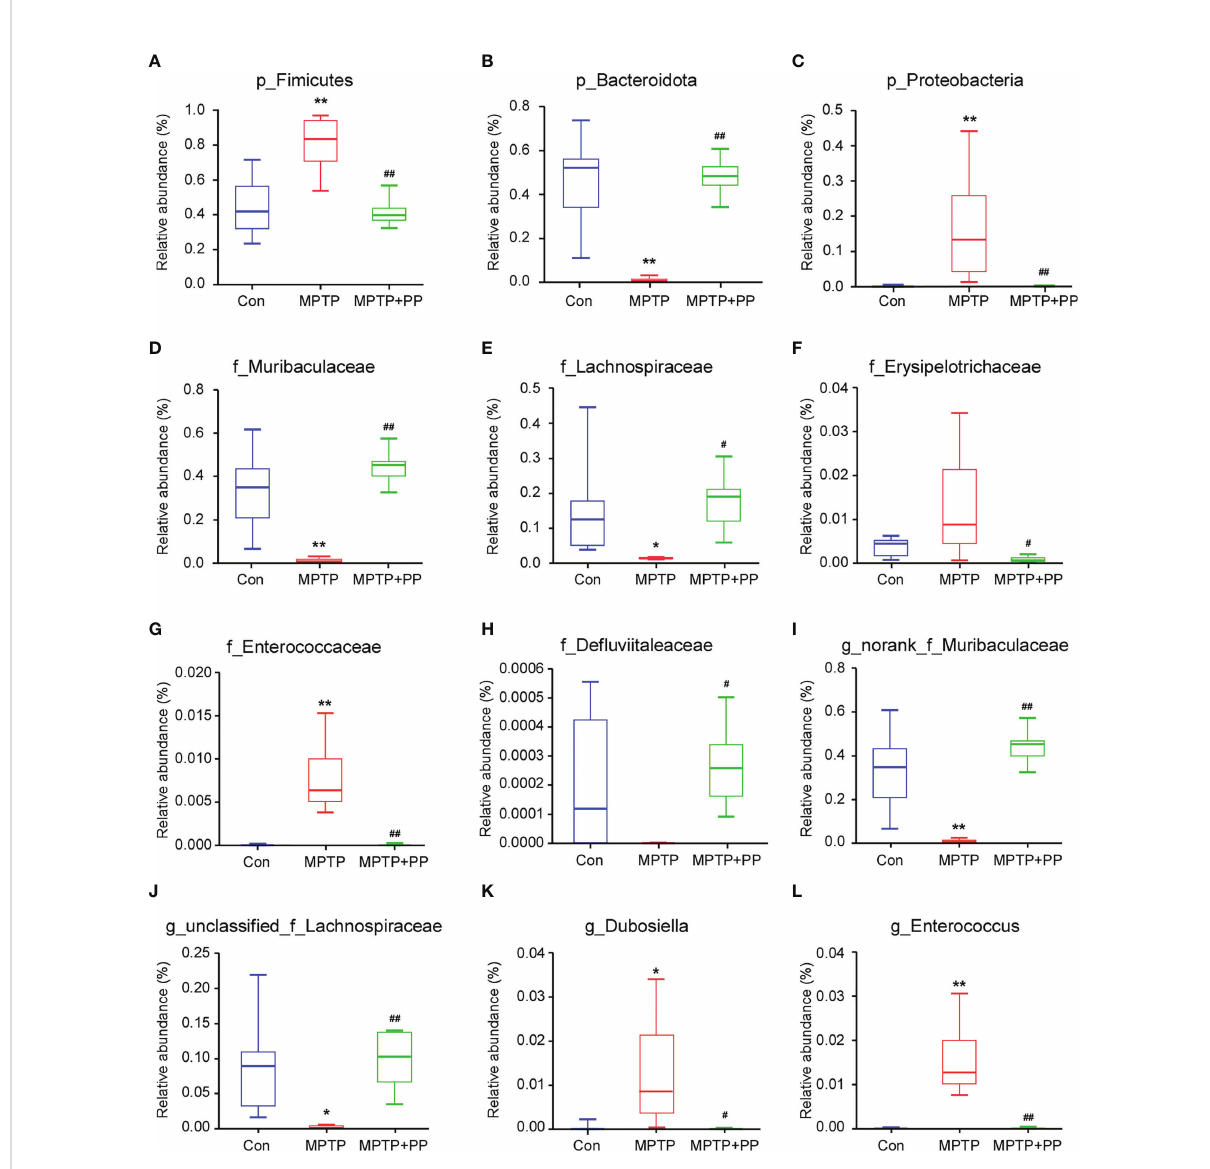
FIGURE 5 Pediococcus pentosaceus treatment reversed the methyl-4-phenyl-1,2,3,6-tetrahydropyridine (MPTP)-induced change of the relative abundance